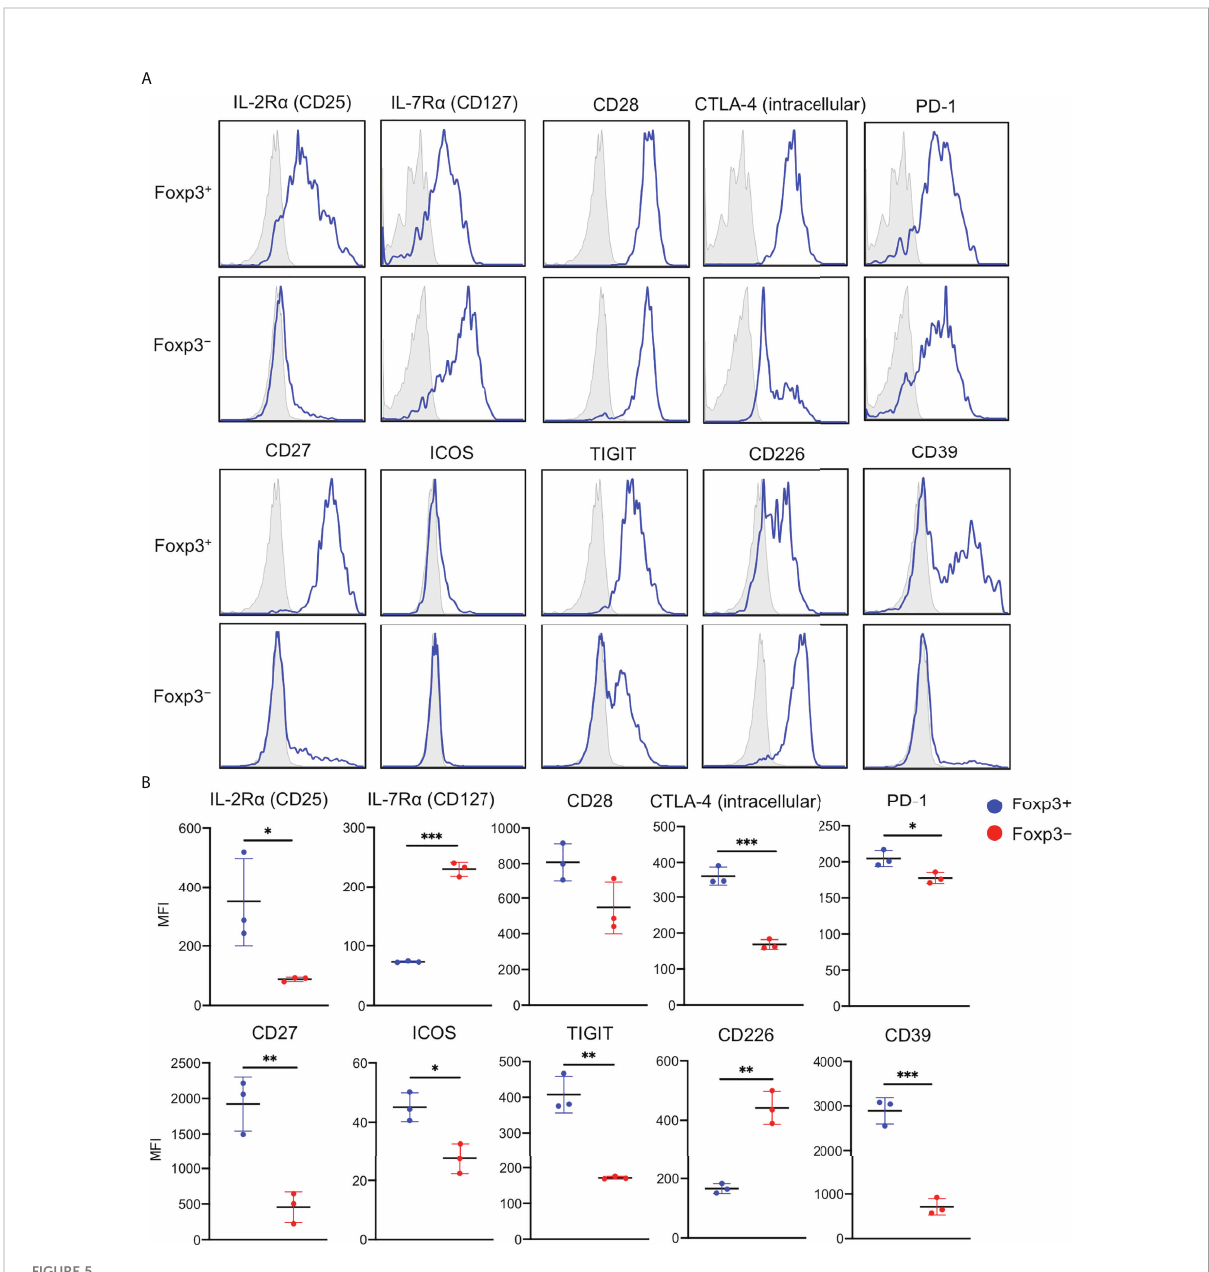
FIGURE 5 Expression of Treg signatures in the epidermal Foxp3 + CD4 + T cells and Foxp3 − CD4 + T cells. (A) Representative expression of indicated antigens in the epidermal Foxp3 + and Foxp3 − CD3 + CD4 + cells. (B) An MFI summary of indicated antigens in the epidermal Foxp3 + and Foxp3 − CD3 + CD4 + cells. All the experiments were conducted using at least three different samples. Comparisons between groups were evaluated using Student ’ s t -test (one-tailed); * p < 0.05, ** p < 0.01, and *** p <